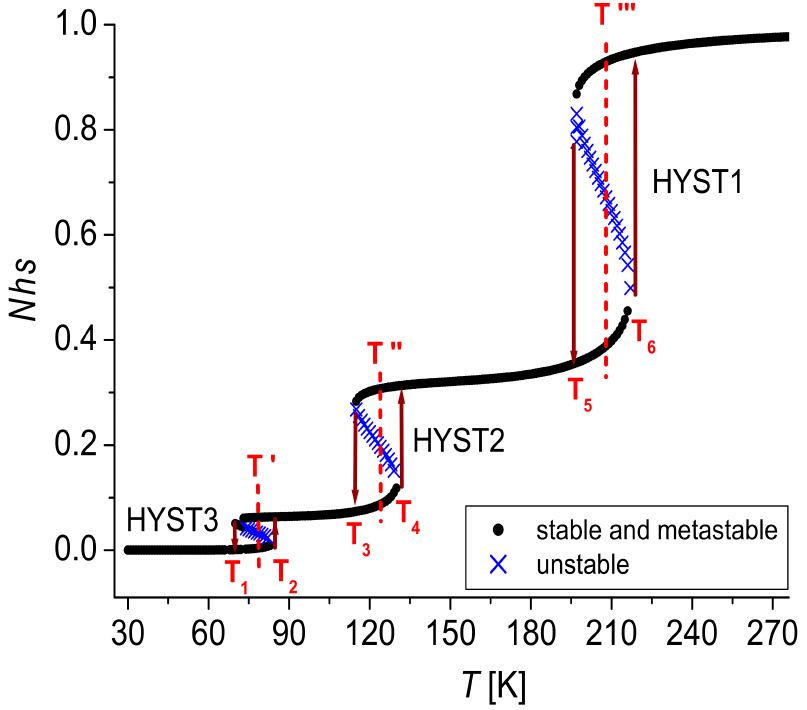
Figure 5. Thermal evolution of the HS molar fraction showing three hysteresis loops—HYST1, HYST2, and HYST3—for the H6 case (91 atoms). Black filled circles represent stable and metastable regions, whereas blue crosses correspond to unstable regions. The computational parameters were ∆ / k B = 1300 K, J / k B = 40 K, G / k B = 70 K, L / k B = 160 K, and ln( g ) =